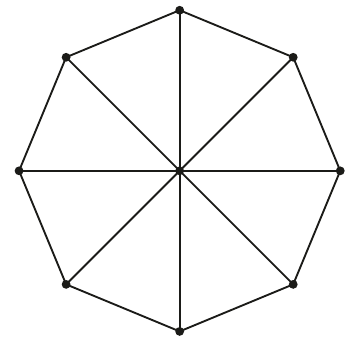
Figure 3: 𝑊 9 as an example of a wheel graph. Figure 4: 𝐾 1,8 as an example of a star